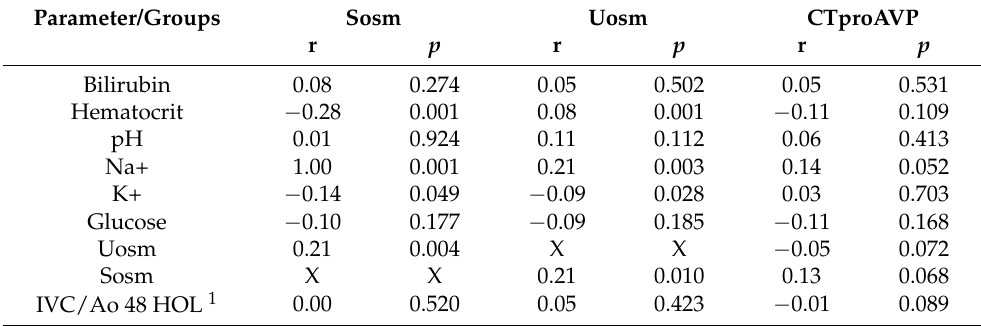
Table 3. Univariate correlations (according to Spearmann) between CTproAVP, effective serum osmolality (Sosm), urine osmolality (Uosm), and biochemical parameters and IVC/Ao ratio. Parameter/Groups Sosm Uosm CTproAVP r p r p r p Bilirubin 0.08 0.274 0.05 0.502 0.05 0.531 Hematocrit − 0.28 0.001 0.08 0.001 − 0.11 0.109 pH 0.01 0.924 0.11 0.112 0.06 0.413 Na+ 1.00 0.001 0.21 0.003 0.14 0.052 K+ − 0.14 0.049 − 0.09 0.028 0.03 0.703 Glucose − 0.10 0.177 − 0.09 0.185 − 0.11 0.168 Uosm 0.21 0.004 X X − 0.05 0.072 Sosm X X 0.21 0.010 0.13 0.068 IVC/Ao 48 HOL 1 0.00 0.520 0.05 0.423 − 0.01